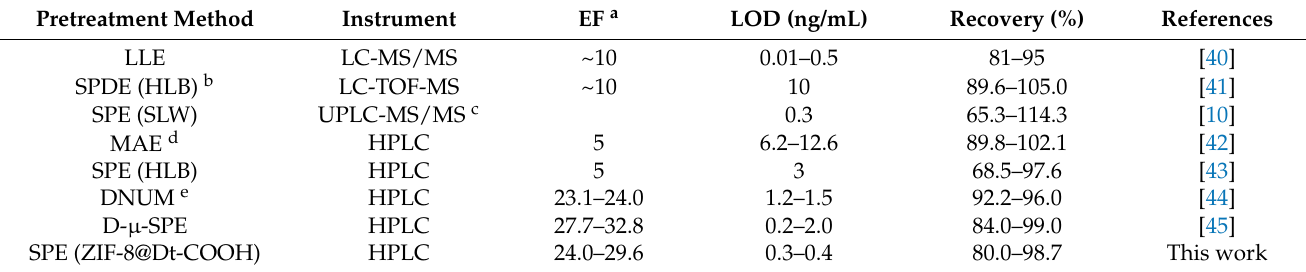
Table 3. Comparison of the proposed method with other methodologies for the determination of BZDs in biological fluids. Pretreatment